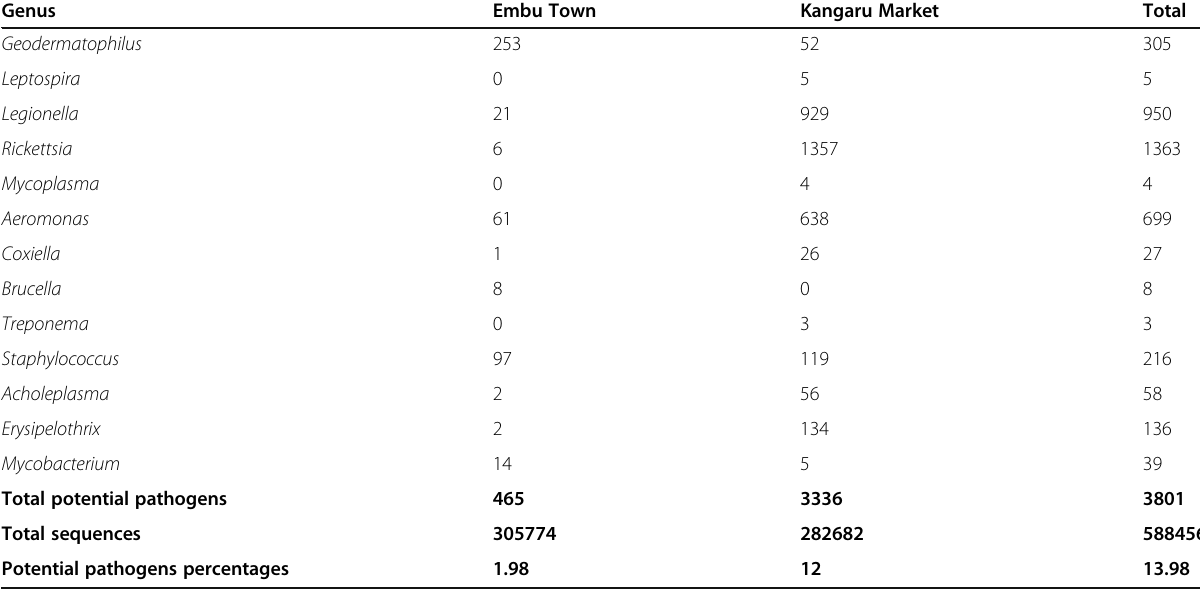
Table 1 Sequences of potentially pathogenic bacteria in food and environmental samples from Embu Town and Kangaru Market Genus Embu Town Kangaru Market Total Geodermatophilus 253 52 305